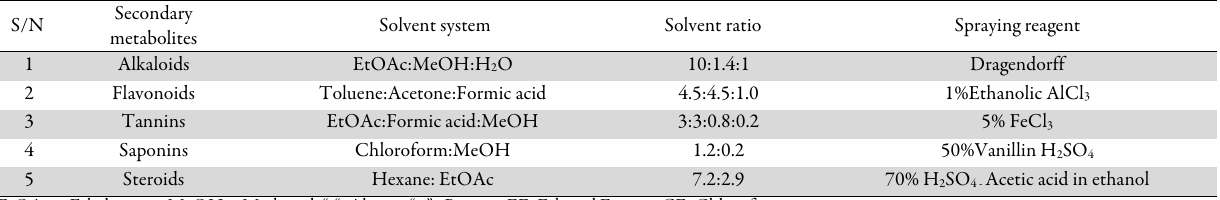
Table 2. Solvent system/spraying reagent used in chromatographic procedure of Ficus leaf extracts